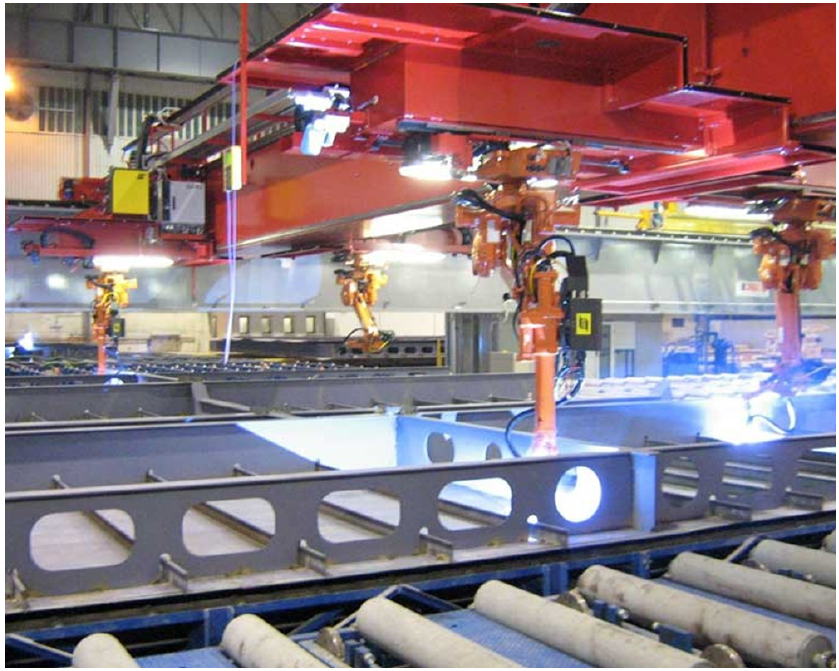
Figure 25. Autonomous welding line robot for shipbuilding (https://www.kranendonk.com/branches/shipbuilding/, accessed date 14 May 2022.)